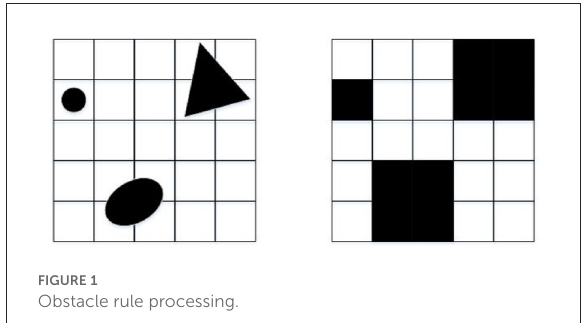
FIGURE1 Obstacle rule